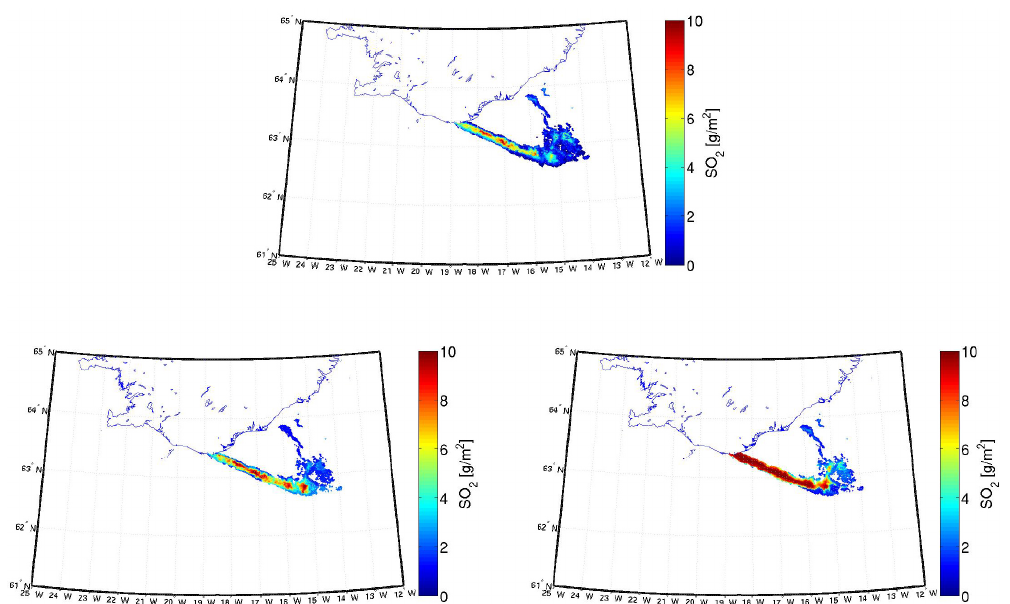
Figure 21. SO 2 columnar abundance maps for 12 May 2010: top, target retrieval; bottom left, retrieval from 3 inputs neural network; bottom right, retrieval from pruned neural network.